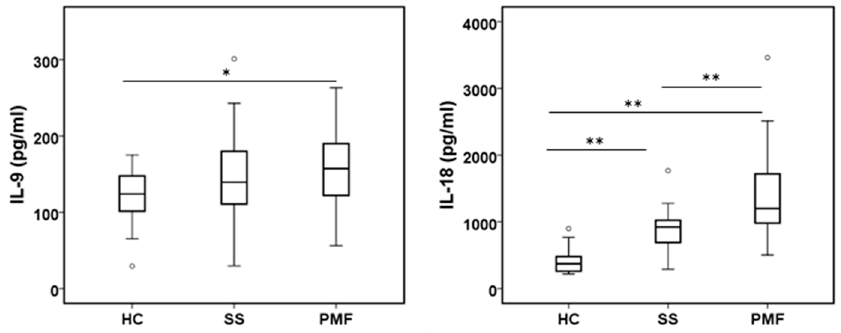
Figure 3. Levels of TH1/TH2 response cytokines in plasma from peripheral blood were assayed in all participants. IL-9 cytokine levels were assayed by the Bio-Plex assay, and IL-18 levels were assayed by the R&D Systems Assay. * and ** indicate significance p < 0.05 and p < 0.01, respectively.